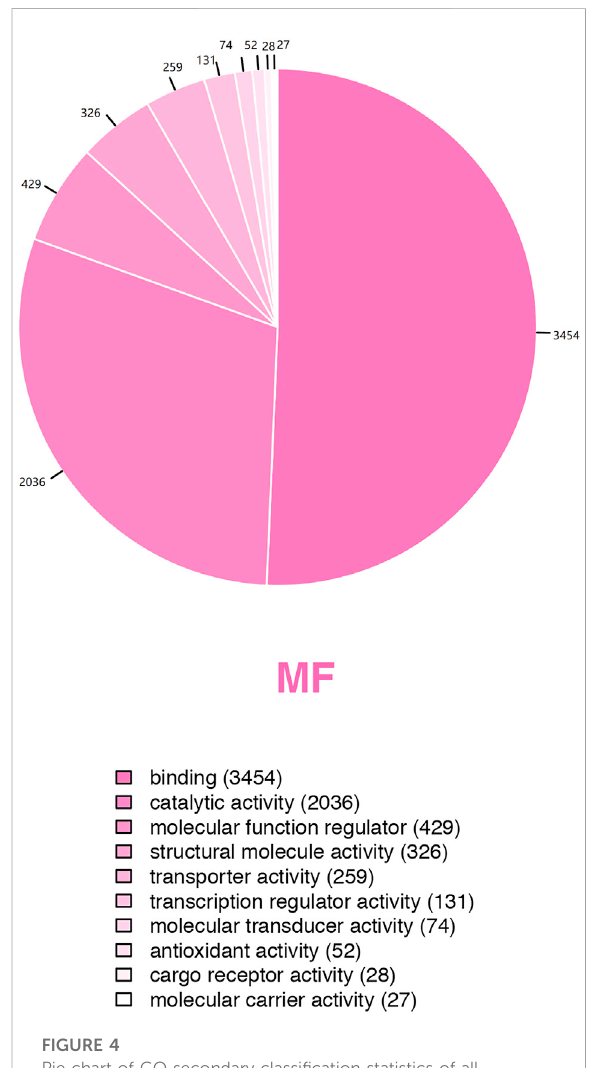
FIGURE 4 Pie chart of GO secondary classi fi cation statistics of all detected